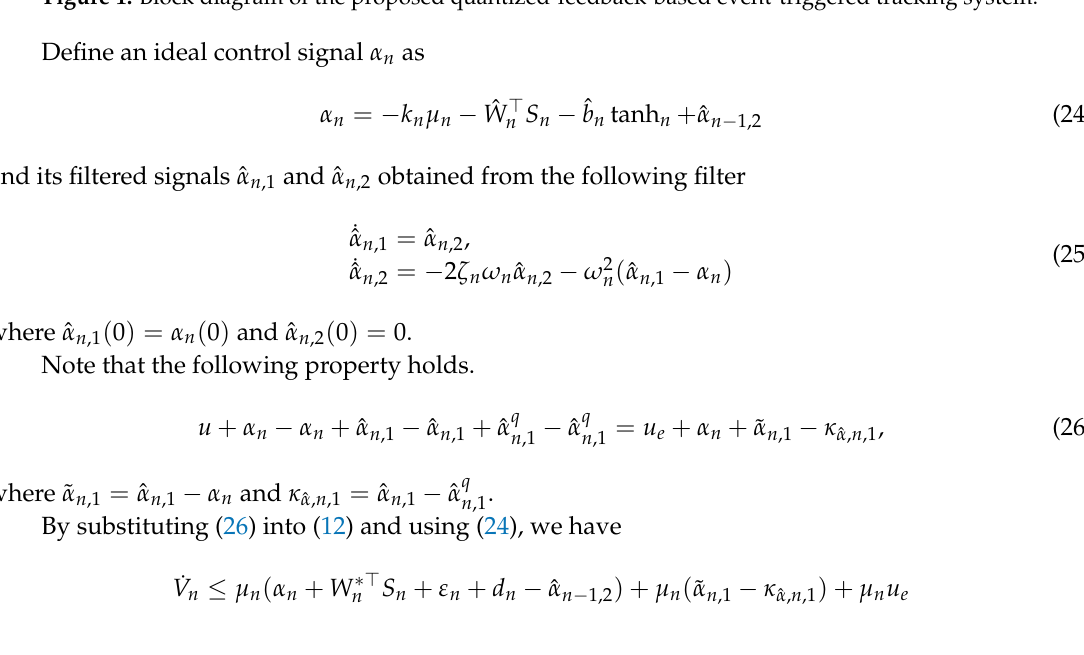
Figure 1. Block diagram of the proposed quantized-feedback-based event-triggered tracking